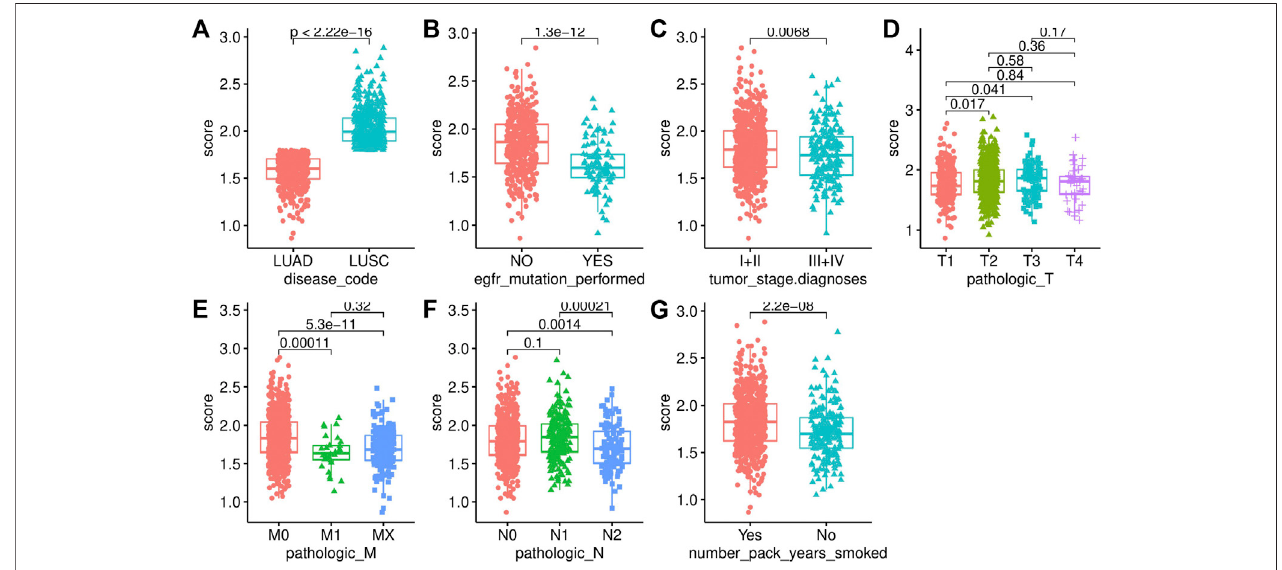
FIGURE 6 | Association analysis with clinical characteristics. (A) Disease code. (B) EGFR mutation status. (C) Tumor stage. (D) T stage. (E) M stage. (F) N stage. (G) Smoking